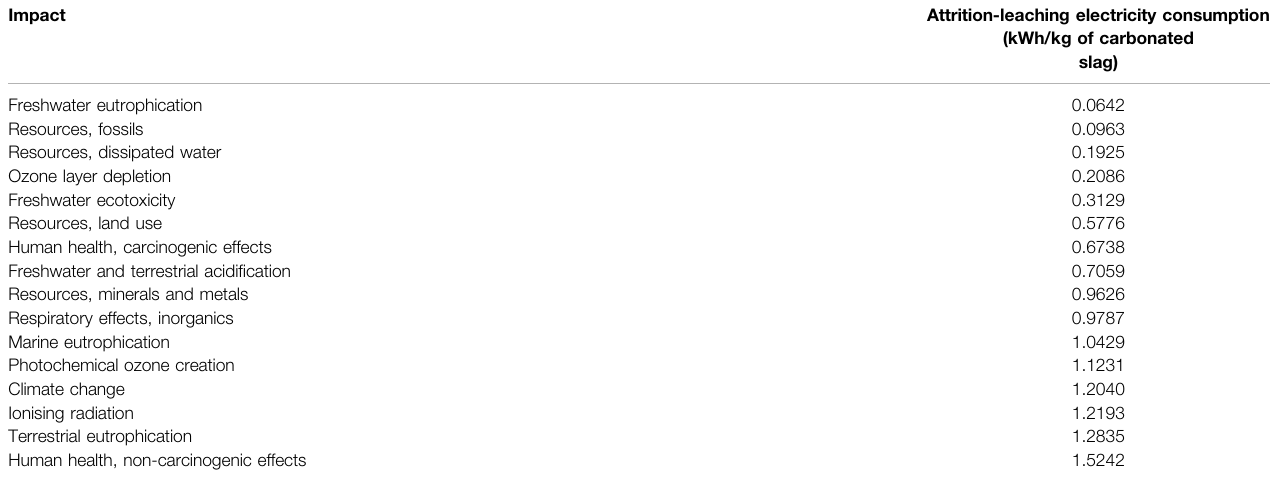
TABLE 6 | Attrition-leaching electricity consumption to achieve the Portland cement impacts, ranked with a decreasing dif fi culty.